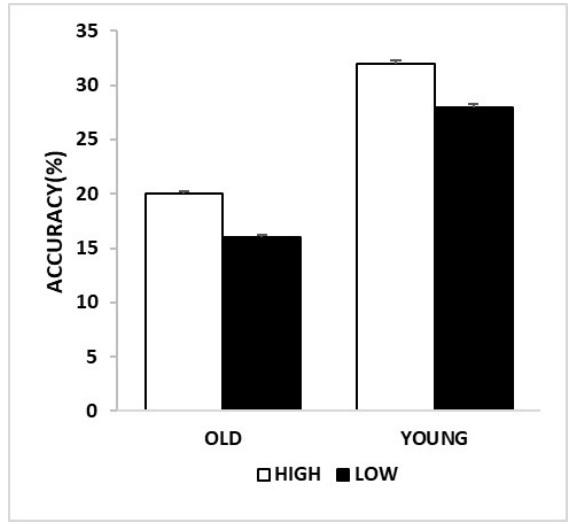
Figure 3. Accuracy for memory of faces: memory performance for levels of curiosity in young and older adults.